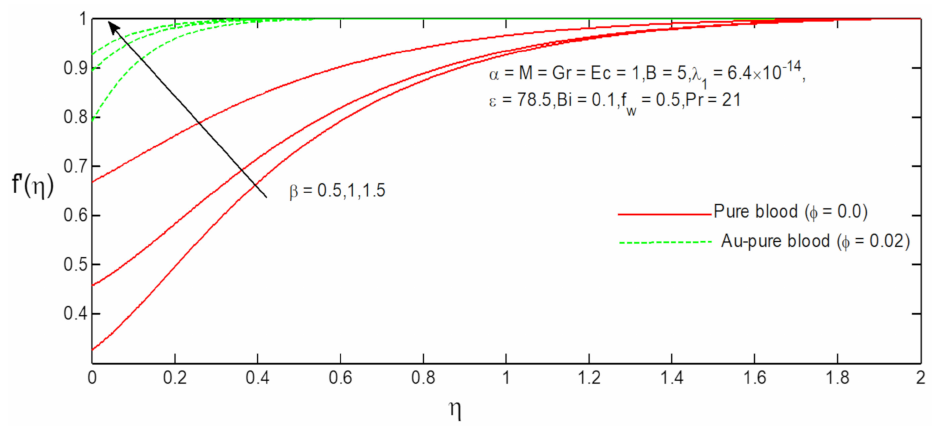
Figure 6. Influence of β on f (cid:48) ( η ) .